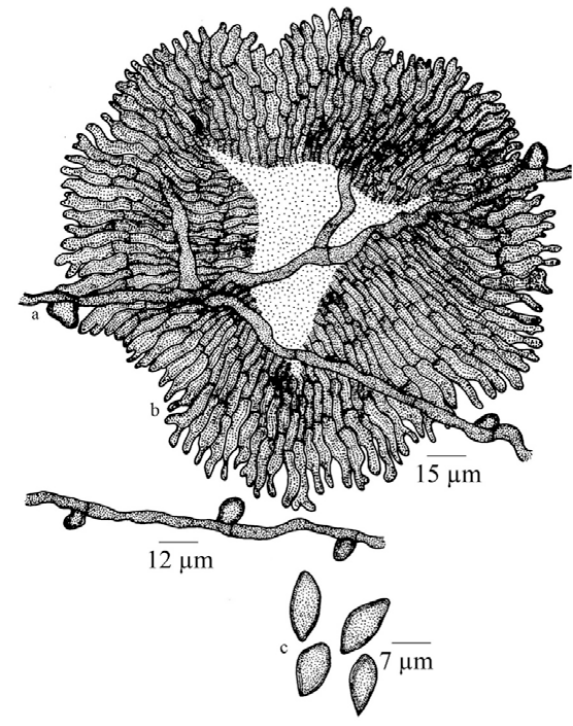
Figure 5. Asterostomella dhanikariensis sp. nov. a - Appressoriate mycelium; b - Pycnothyrium; c -